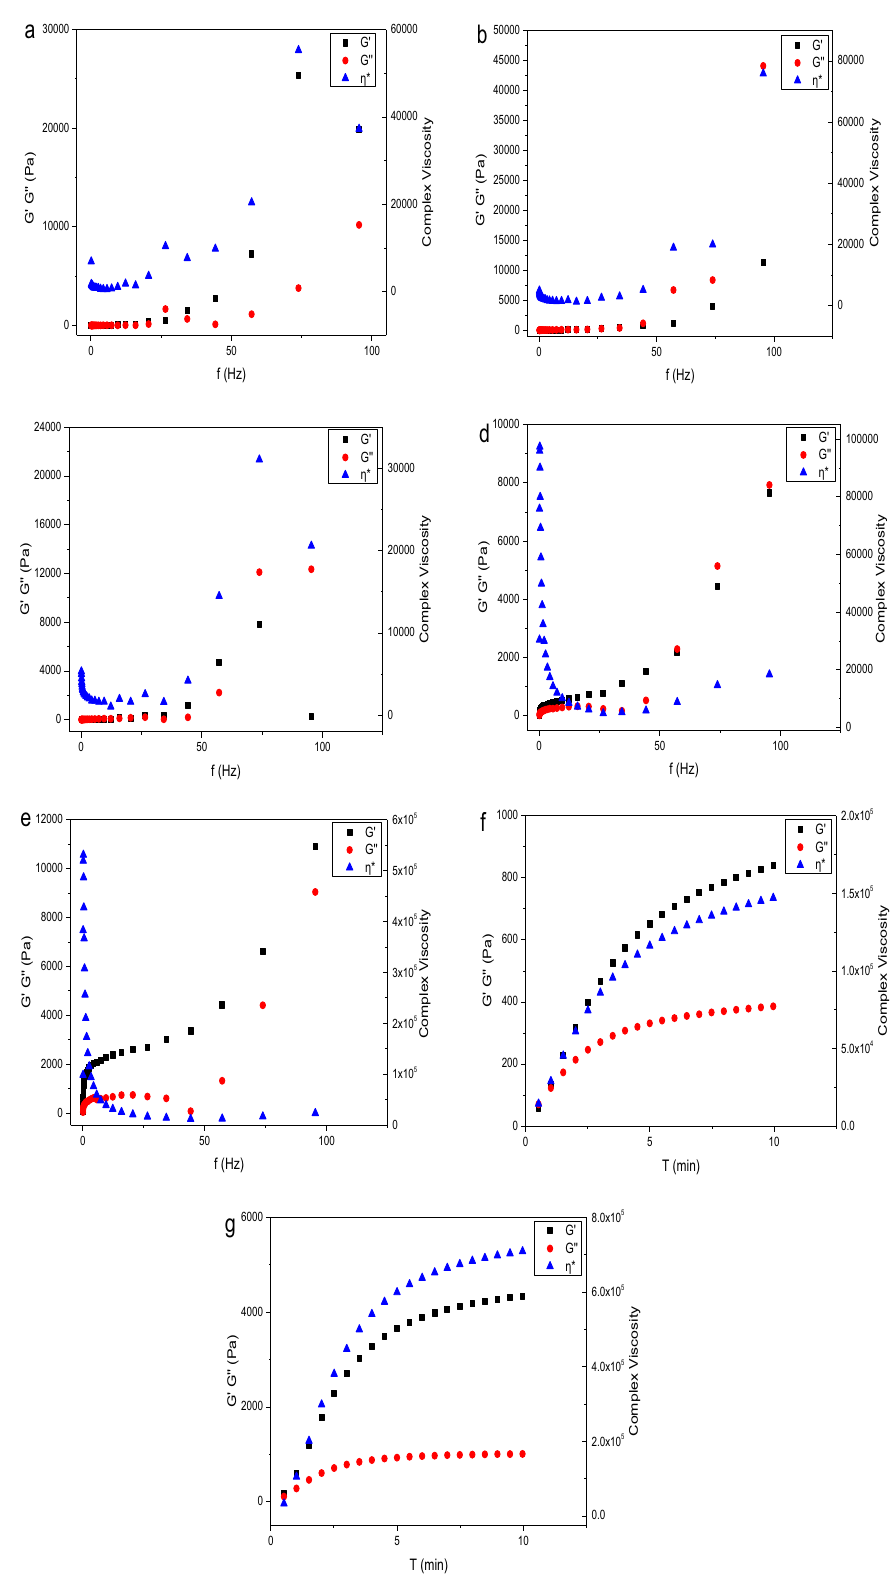
Figure 8. Rheological test [( a – c ) the frequency sweep test of SA-CMC, PDMA, PAA solution; ( d , e ) the frequency sweep test of the crosslinking process of SA-CMC@PDMA-1and SA-CMC@PAA-1, respectively; ( f , g ) time test of the crosslinking process of SA-CMC@PDMA-1and